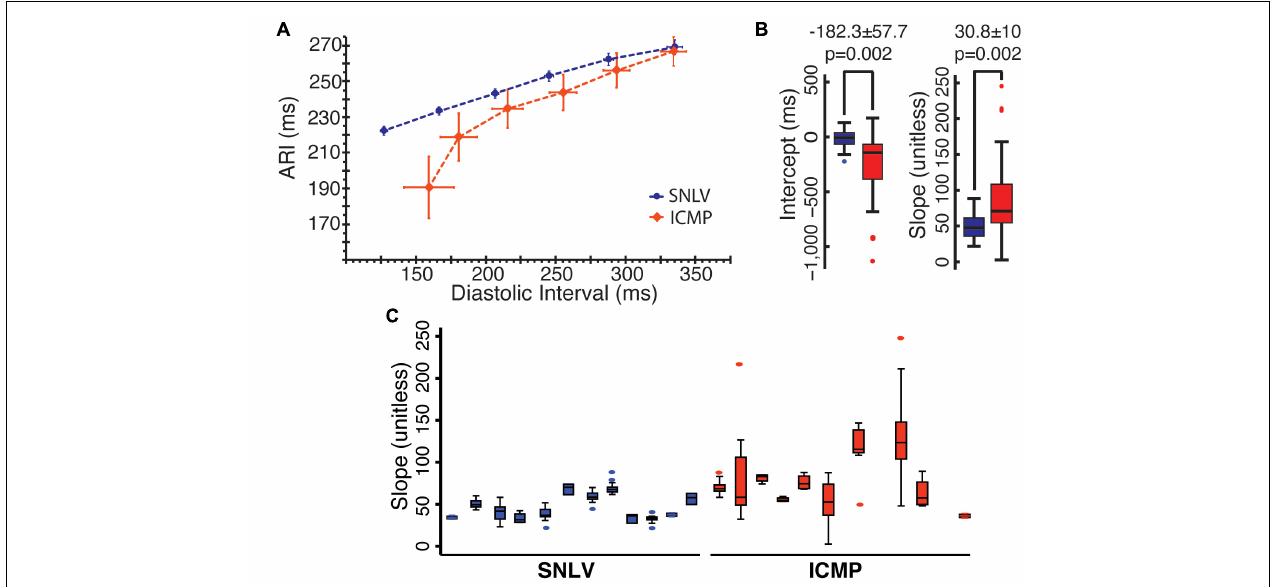
FIGURE 1 | (A) ARI over DI in patients with SNLV (blue) and ICMP (red). Points represent mean values and error bars represent 95% confidence intervals. ARI, activation recovery interval in ms; DI, diastolic interval in ms. (B) Box-plots demonstrating the distribution of clinically obtained APDR intercept (in ms) and slope (unitless) in patients with SNLV (blue) and ICMP (red). Box-plots summarize the intercept and slope of the clinically obtained APDR curve fitted at each UniEGM recording of each patient. p -values are derived from mixed model analysis as described in the main text. (C) Box-plots of the clinically obtained APDR slope in each individual SNLV and ICMP patient, demonstrating the within- and between-subject variability of clinically obtained APDR slope.